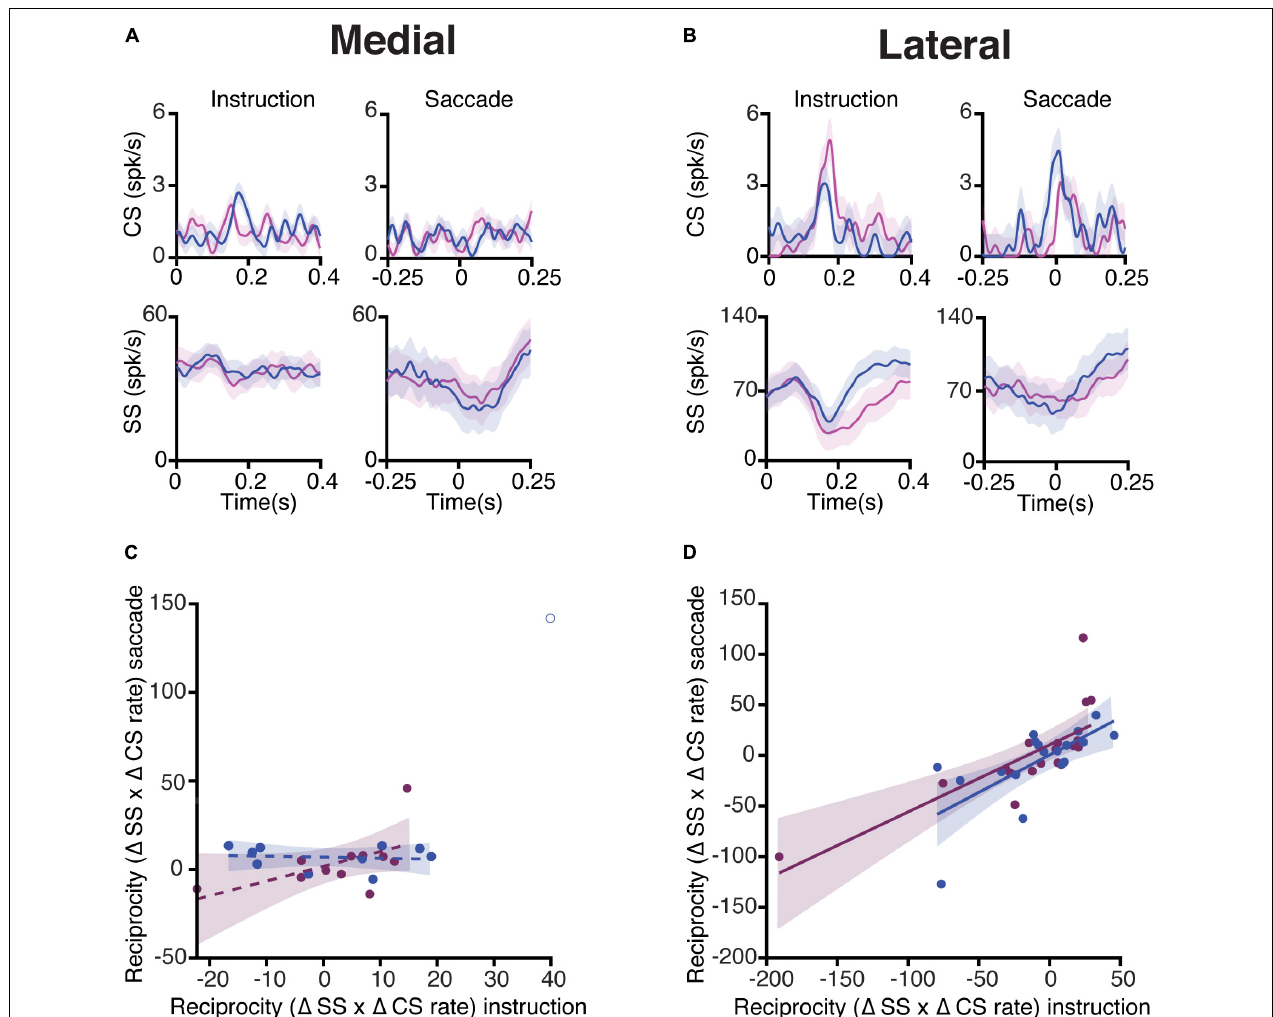
FIGURE 5 | Complex spike and simple spike interaction during pro- and anti-saccade trials. (A) Top, average CS rate of PCs in the medial cerebellum during prosaccades (magenta) and antisaccades (blue) aligned to the onset of the instruction (left) and saccade (right) periods. The bottom panels show the associated SS responses. Shaded areas represent the standard error of the mean (SEM). (B) Same as (A) , but for neurons recorded in the lateral cerebellum. (C) Relation of reciprocity between CS and SS responses during the instruction and saccade periods. To quantify the reciprocity, we calculated the maximum change in the CS firing rate in the windows of interest (instruction and saccade periods), the associated maximum change in the SS rate in a window of 300 ms around the peak of CS activity, and subsequently the product of the two ( (cid:49) CS rate × (cid:49) SS rate). Note that if a positive modulation of CSs is associated with a negative modulation of SSs, the reciprocity measure presented here will give a negative value. If CSs and SSs show simultaneous positive modulations, and thus no reciprocity, this will result in a positive value. Every dot represents one cell. The coefficients of determination ( R 2 ) are as follows: medial pro = 0.03, medial anti = 0.01. (D) Same as (C) but of lateral neurons, coefficients of determination: lateral pro = 0.54, and lateral anti = 0.42. Shading indicates a 95% CI of the regression